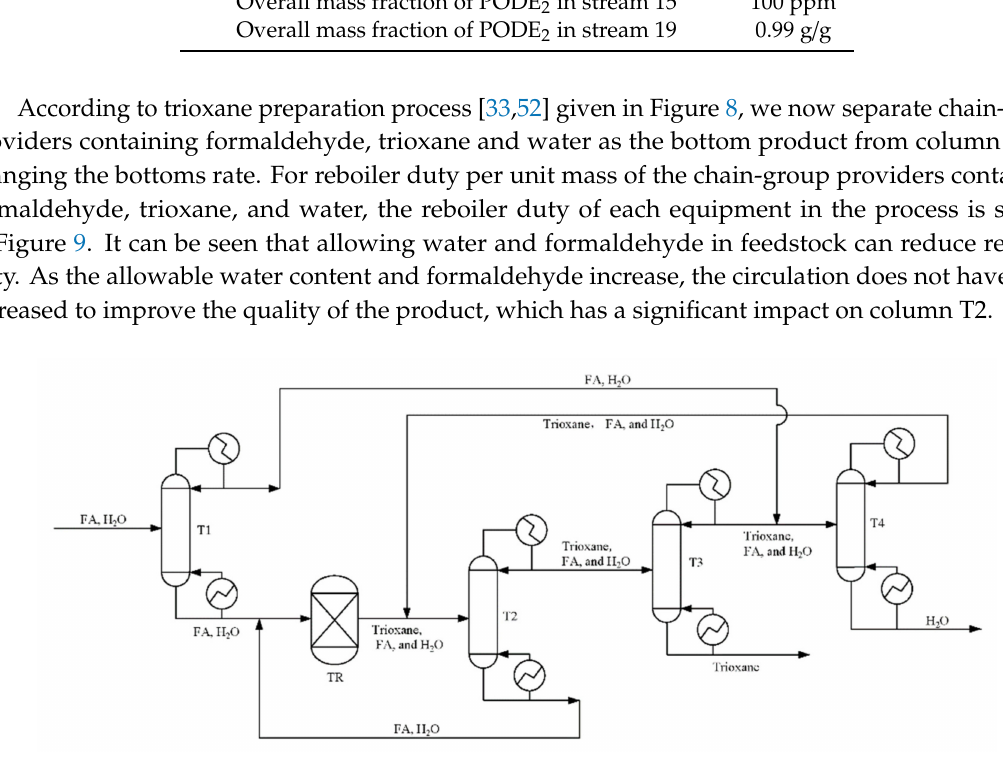
Figure 8. Flowsheet of the highly concentrated chain-group providers containing formaldehyde, trioxane, and water production